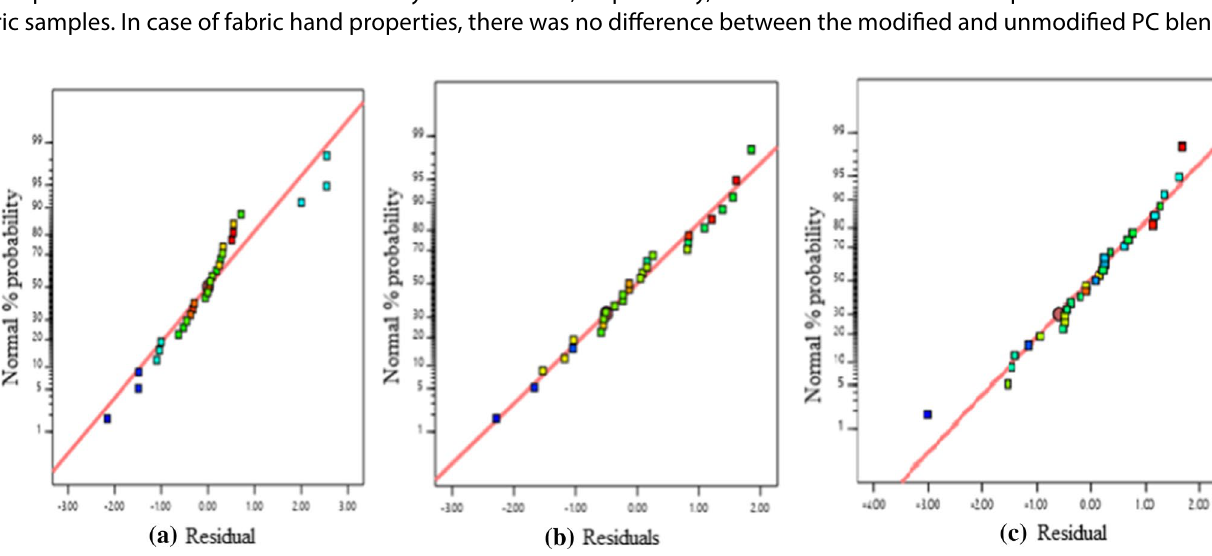
Fig. 9 Normal % probability vs residual plots for a color strength and tensile strength in the warp b and weft c